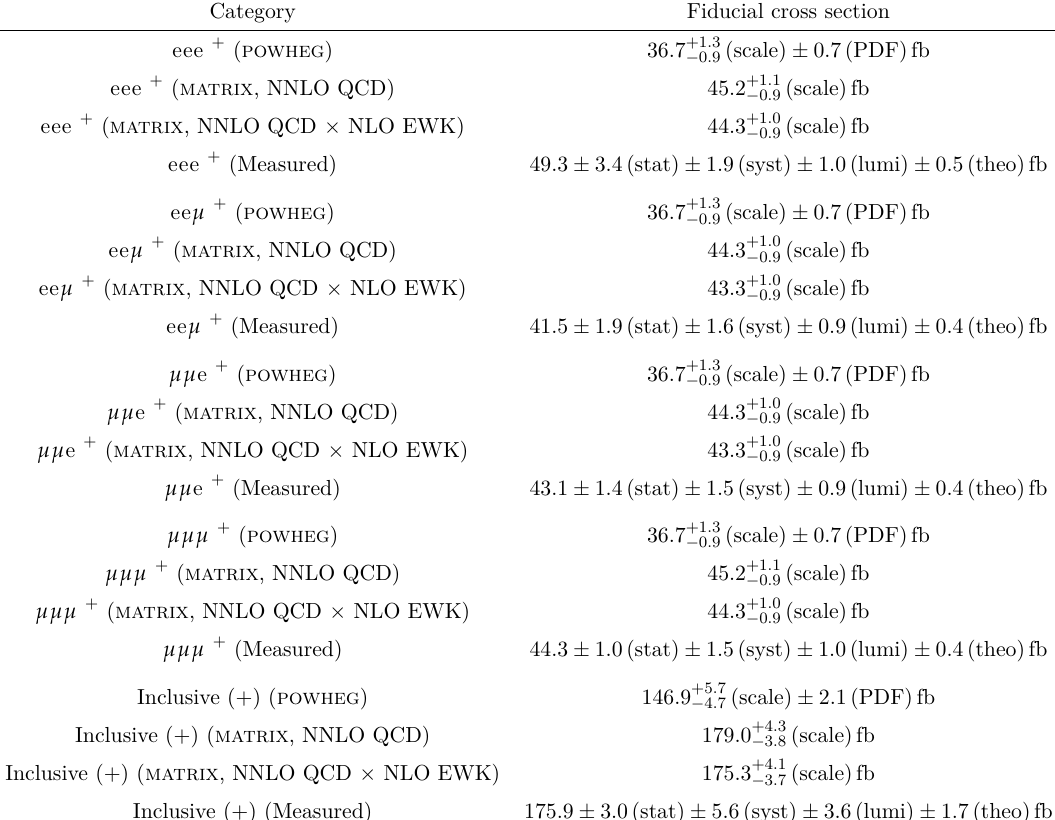
Table 8 . Measured fiducial cross sections and their corresponding uncertainties for each of the individual flavour categories, as well as for their combination, for positively charged final states. The predictions from both matrix (at NNLO QCD and NNLO QCD × NLO EWK) and powheg (at NLO QCD) are also